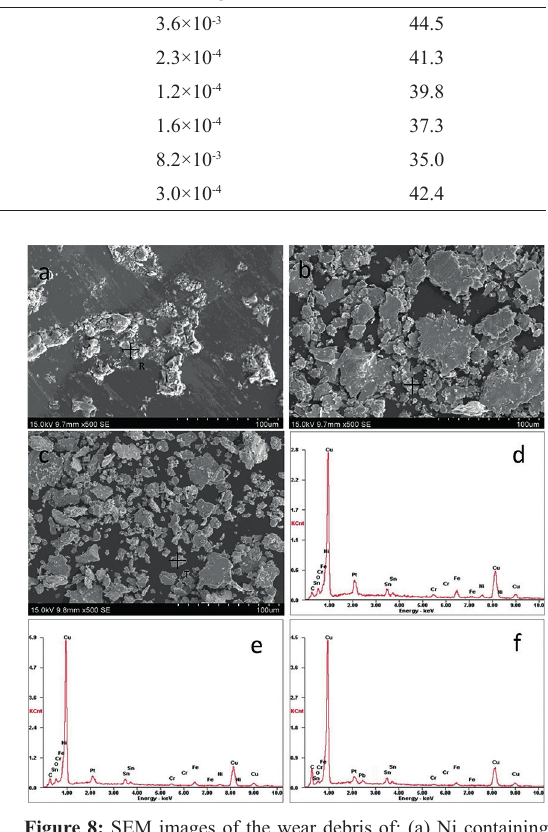
Figure 8: SEM images of the wear debris of: (a) Ni containing graphite-CuSn10 composite layers with 10 vol% graphite, (b) no Ni containing graphite-CuSn10 composite layers with 10 vol% graphite, (c) CuSn10Pb10 alloy layers. (d) EDS pattern of point